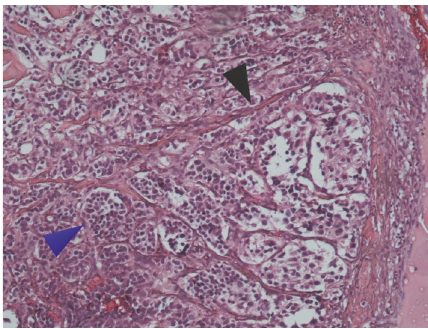
Figure 4: Histopathological appearance of CBP (16-year-old teenage girl) showing “zellballen” growth pattern of paragangliomas with centralround/ovalchiefcellscontainingabundanteosinophilic granular or vacuolated cytoplasm, uniform nuclei with dispersed chromatin-nests of cells (blue arrow). Prominent fibrovascular stroma separates nests (black arrow).